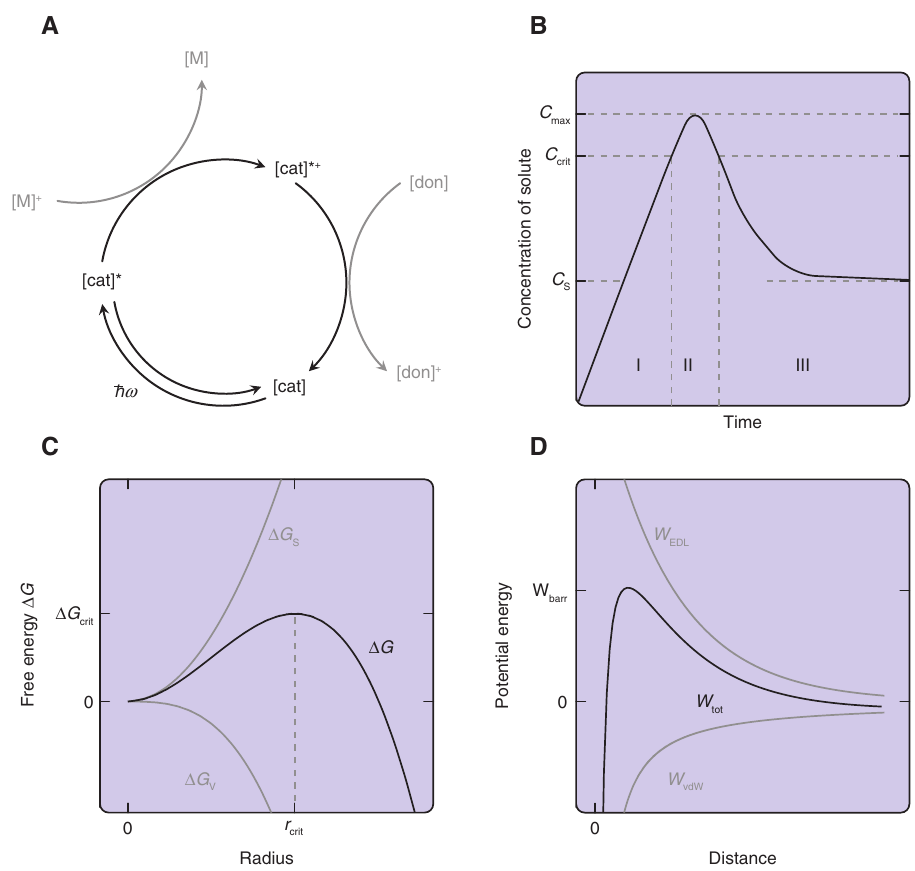
Figure 2: Post excitation processes. (A) Oxidative quenching cycle of a catalyst [cat] excited by photons. The catalyst reduces a metal ion [M + ] to neutral metal [M] and is oxidized. The oxidized catalyst returns to its original state after being reduced by a sacrificial electron donor. (B) Scheme of the evolution of nucleation according to the LaMer model. (I) Increase of neutral metal concentration by reduction. (II) At a concentration of C , the activation barrier crit of nucleation is overcome leading to rapid self-nucleation (burst nucleation). The concentration of neutral metal is thus quickly reduced and lowered below C and terminates nucleation. (III) Diffusion-controlled growth further reduces the concentration and finally leads to a crit constant level. (C) Scheme of the surface ( ∆ G ) and volume ( ∆ G ) term of the cluster free energy ∆ G . The maximum free energy a nucleus has S V during nucleation ∆ G is reached at the critical radius r . This radius corresponds to the minimal size a nucleus needs to have to remain crit crit stable in solution. (D) Scheme of the interaction potential of two nanoparticles. The interaction potential W is the sum of the van der Waals tot potential W and the electrostatic interaction potential W due to the electrical double vdW EDL